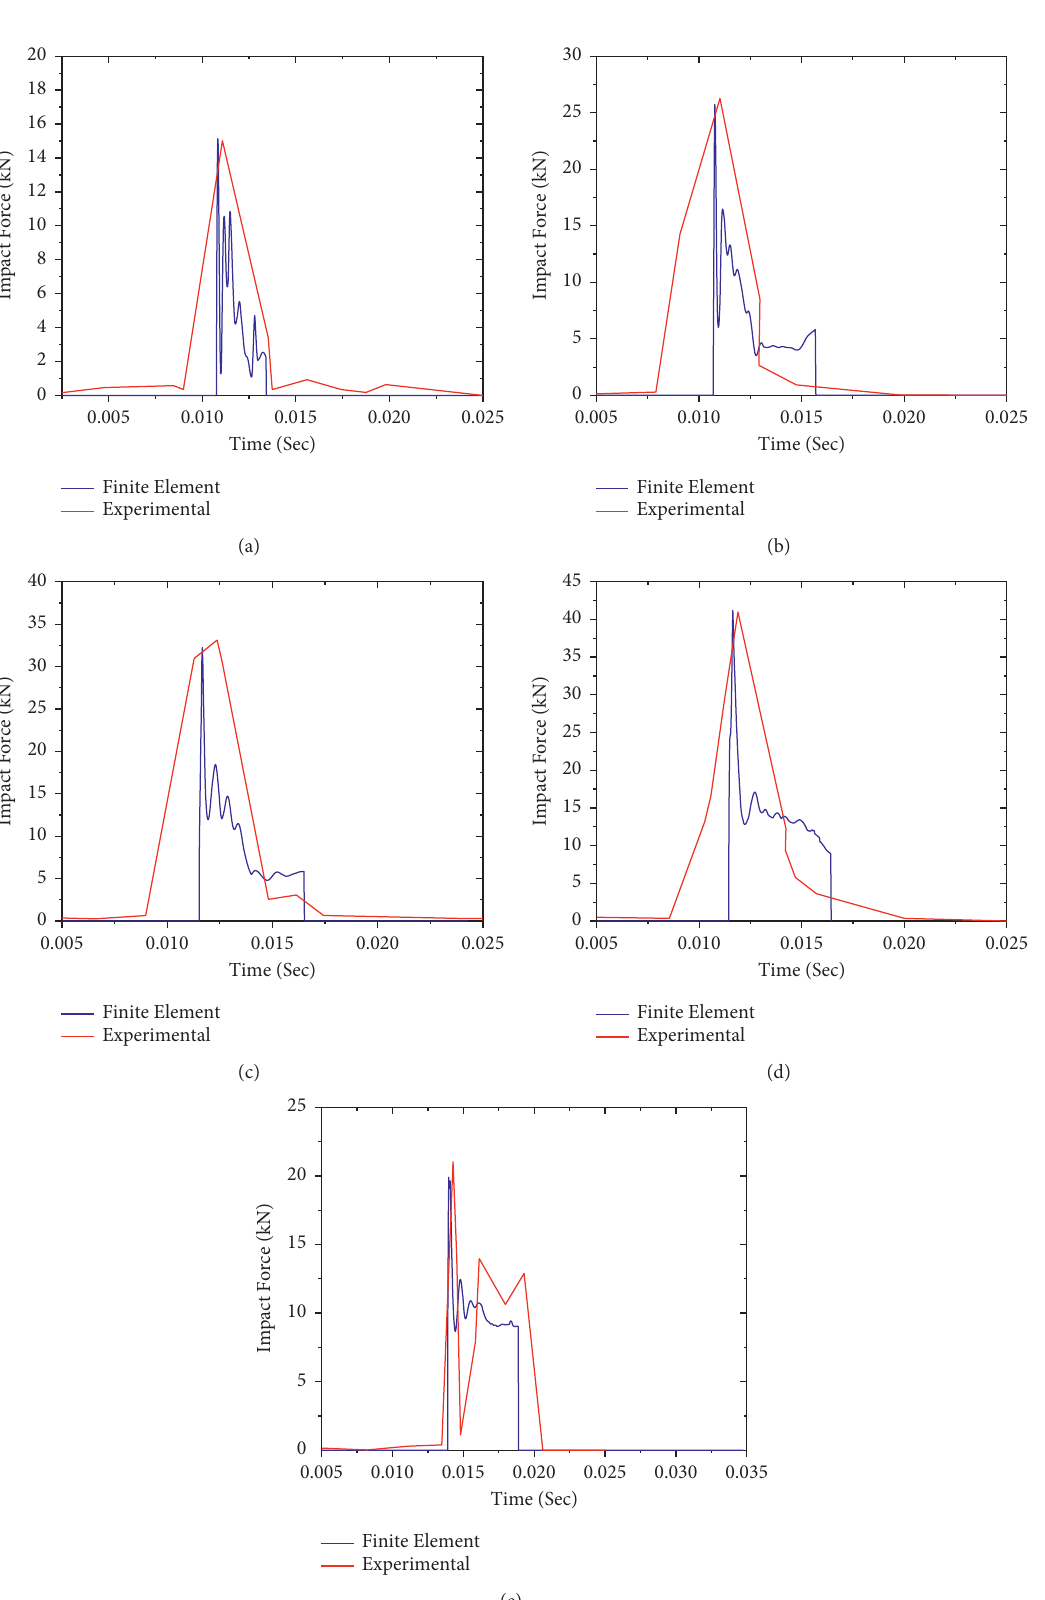
Figure 11: Impact force-time histories of numerical along with experimental test results: (a) 1 st impact; (b) 2 nd impact; (c) 3 rd impact; (d) 4 th impact; (e) 5 th